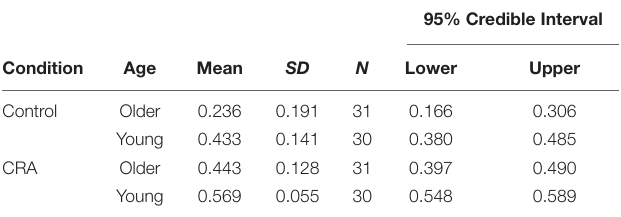
TABLE 6 | Descriptive statistics for the recognition memory performance (hits-misses).